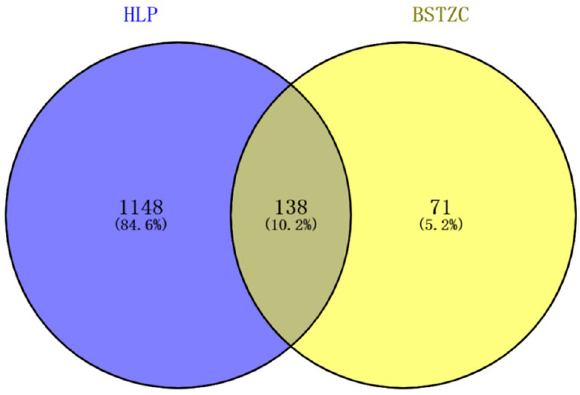
Figure 2. Venn diagram of related targets of BSTZC and